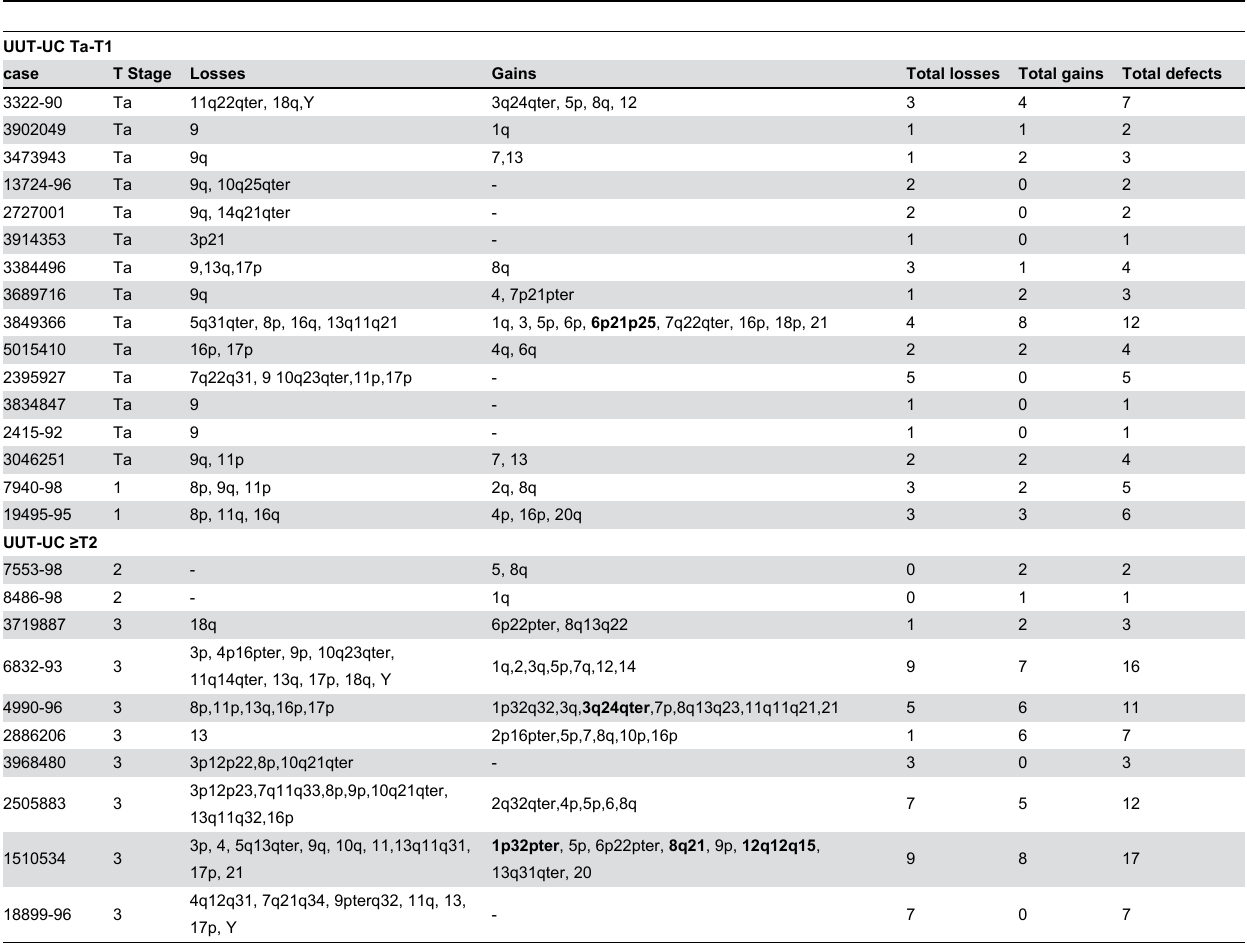
Table 3. CGH results of Upper urothelial tract-urothelial carcinomas (UUT-UC) in detail.